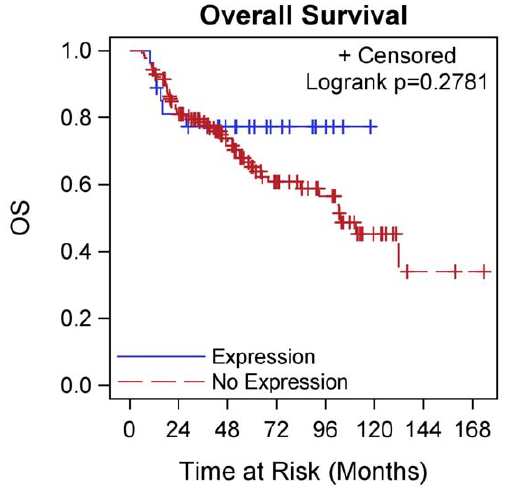
Figure 2. OS by NY-ESO-1 expression in TNBC. Kaplan-Meier curve showing OS differences in patients with TNBC stratified by NY- ESO-1 expression.